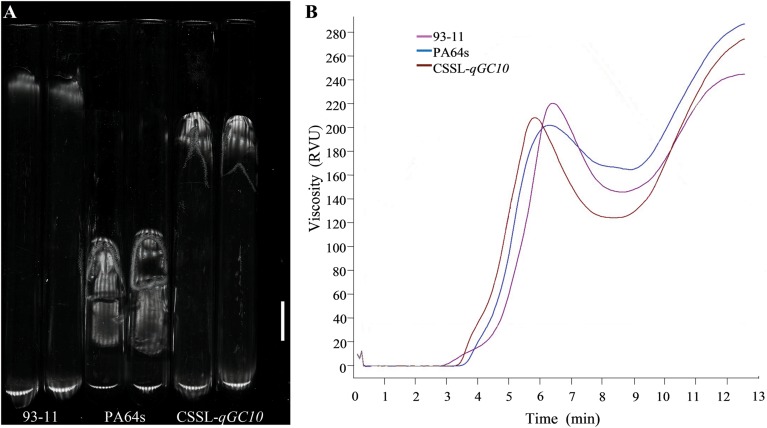
GC phenotype and Rapid Visco Analyzer (RVA) profile characteristic values in 93-11, PA64s and CSSL-qGC10. (A) GC phenotype in 93-11, PA64s and CSSL-qGC10. Rice flour becomes rice paste glue after dilute alkali and heat treatment. It has a certain degree of extension when cooling in the horizontal tube with total length of 100 mm, and the extended length represents GC value. (B) RVA profile characteristic values in 93-11, PA64s and CSSL-qGC10. The RVA spectrum simulates the process of rice cooking and reflects the taste and texture of rice. RVA is represented by Relative Viscosity Units (RVU).